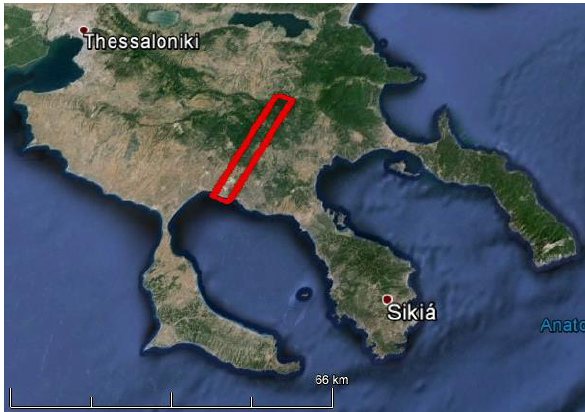
Figure 1. The study site is located in Chalkidiki peninsula, Northern